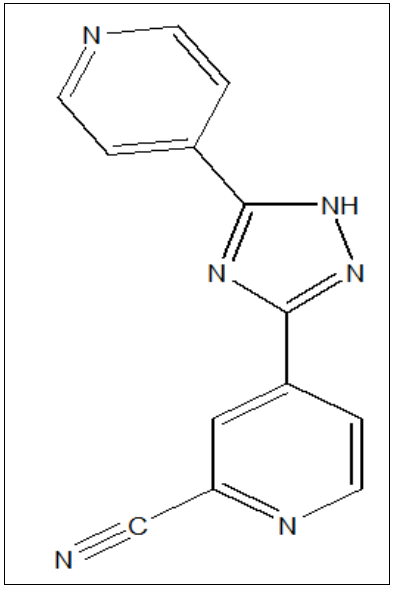
Figure 3: The chemical structure of topiroxostat